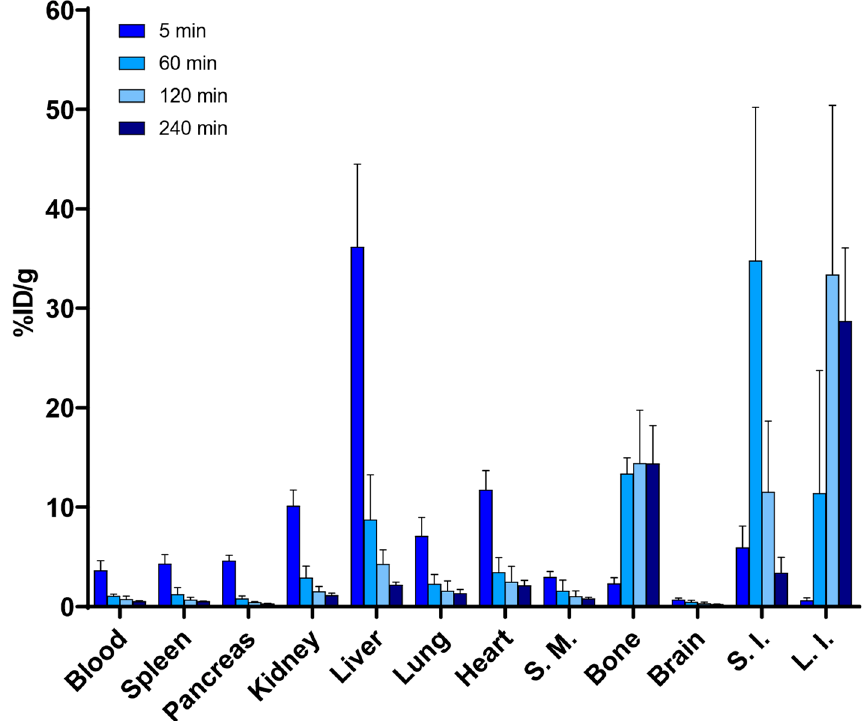
Figure 4. Biodistribution of radioactivity after the intravenous injection of [ 18 F]SiFA-Tz ([ 18 F] 6 , n = 3), demonstrating a high bone uptake of radioactivity, 60 min post-injection. (S.M.—skeletal